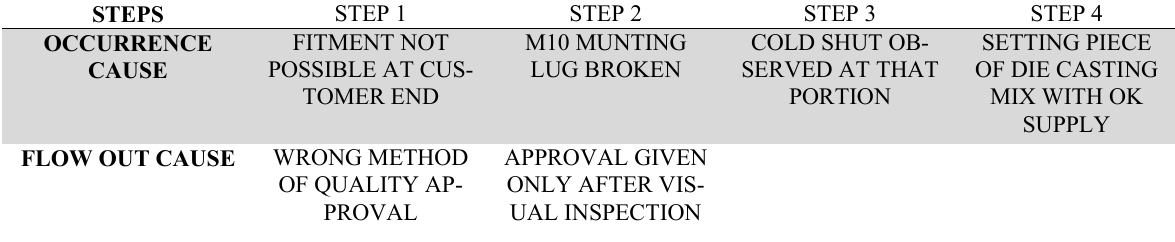
SETTING PIECE PORTION